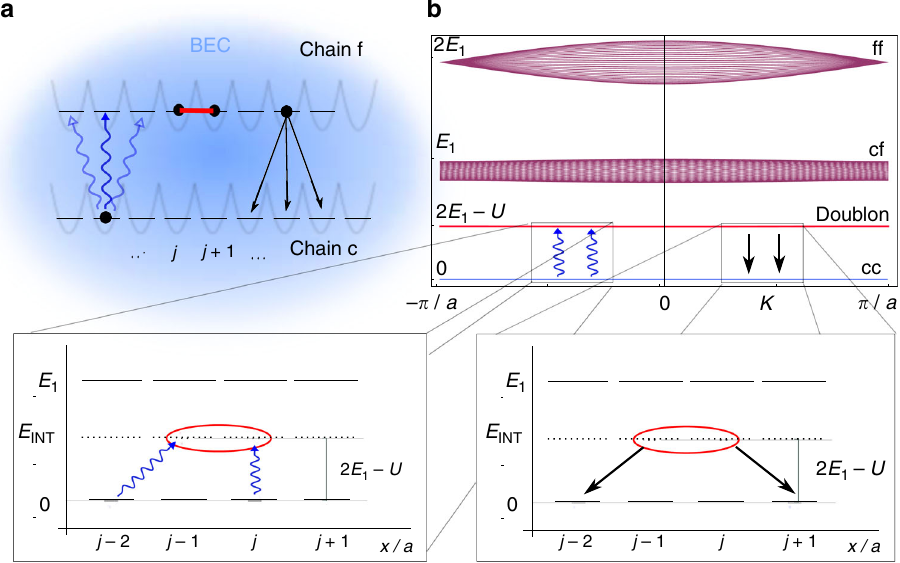
Fig. 2 Implementation of Lindblad operators. a Two chains c and f fi lled with fermions are immersed in a bath, realized as a Bose – Einstein condensate (BEC). Transitions between the two chains that have different chemical potential are mediated by the absorption of a photon from an external laser (blue wavy lines), or due to the relaxation induced by the bath (black arrows). Particles in the upper band are subject to nearest neighbor attractive interactions, of magnitude U (red line). b Two-particle excitation spectrum, consisting of three free-particle bands (cc, cf, and ff) and the doublon band as a function of the total momentum of the pair. The laser frequency is red detuned from the transition energy 2 E 1 − U , so that the laser mainly creates doublon excitations. b Left inset: In second-order perturbation theory in Ω , the radiation couples the lower two-particle band with the doublon band. b Right inset: These excitations can decay back to the lower band by emitting phonons in the